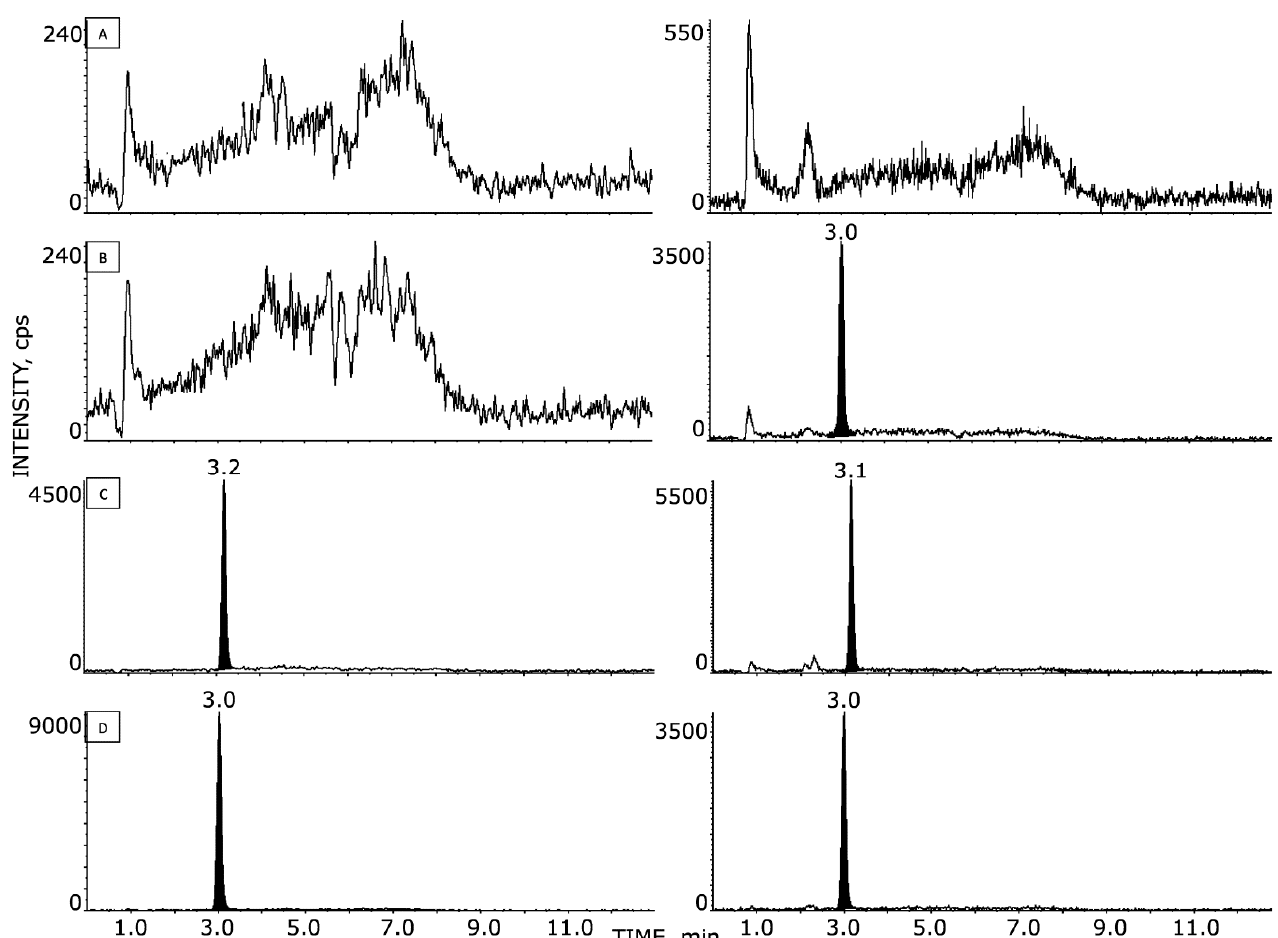
Figure 3. HPLC–MS/MS chromatograms of NAZ in murine brain tissue: ( A ) blank sample; ( B ) blank sample with added IS; ( C ) NAZ at the LLOQ (i.e., 2 ng/g); ( D ) NAZ and IS of an extracted sample 1 h after the last NAZ administration; the measured concentration corresponds to 9.2 ng/g.